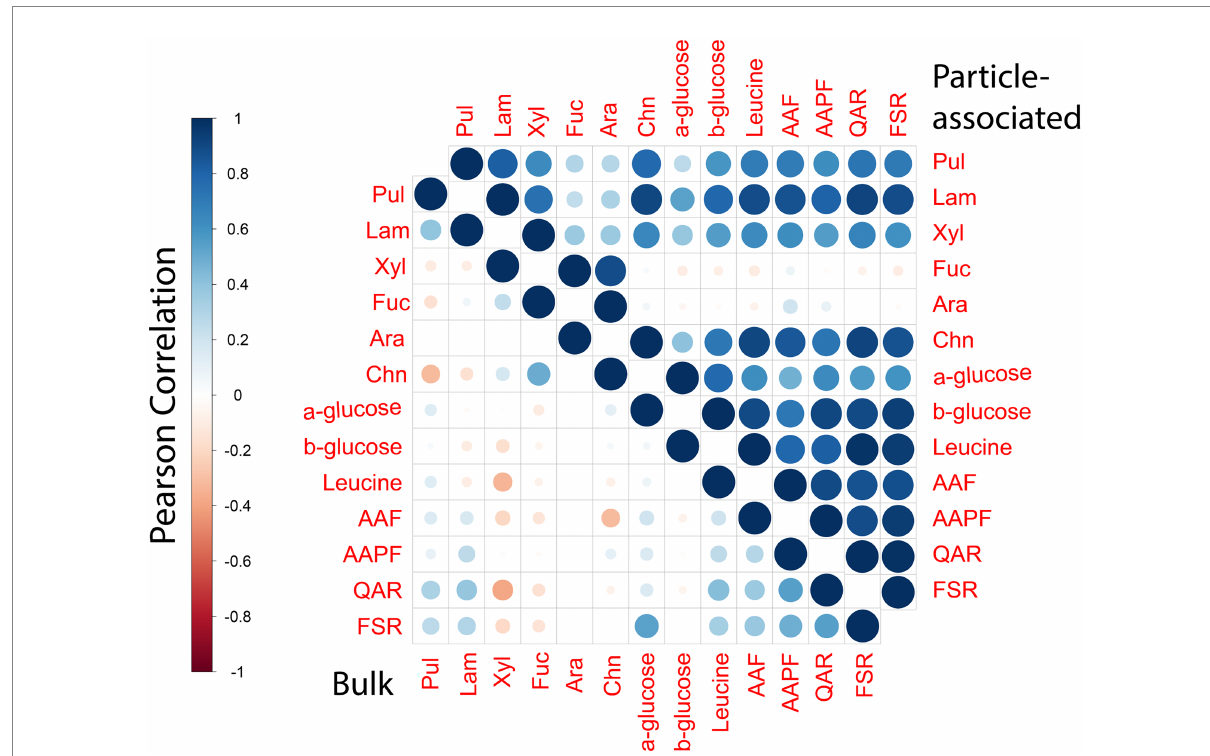
FIGURE 7 Correlation plot displaying the Pearson’s correlation between different enzymatic activity measurements for bulk and PA samples. Blue denotes positive correlation while red denotes negative correlations. The size of the circle as well as the shade of the color emphasizes the extent of correlations between different enzymatic